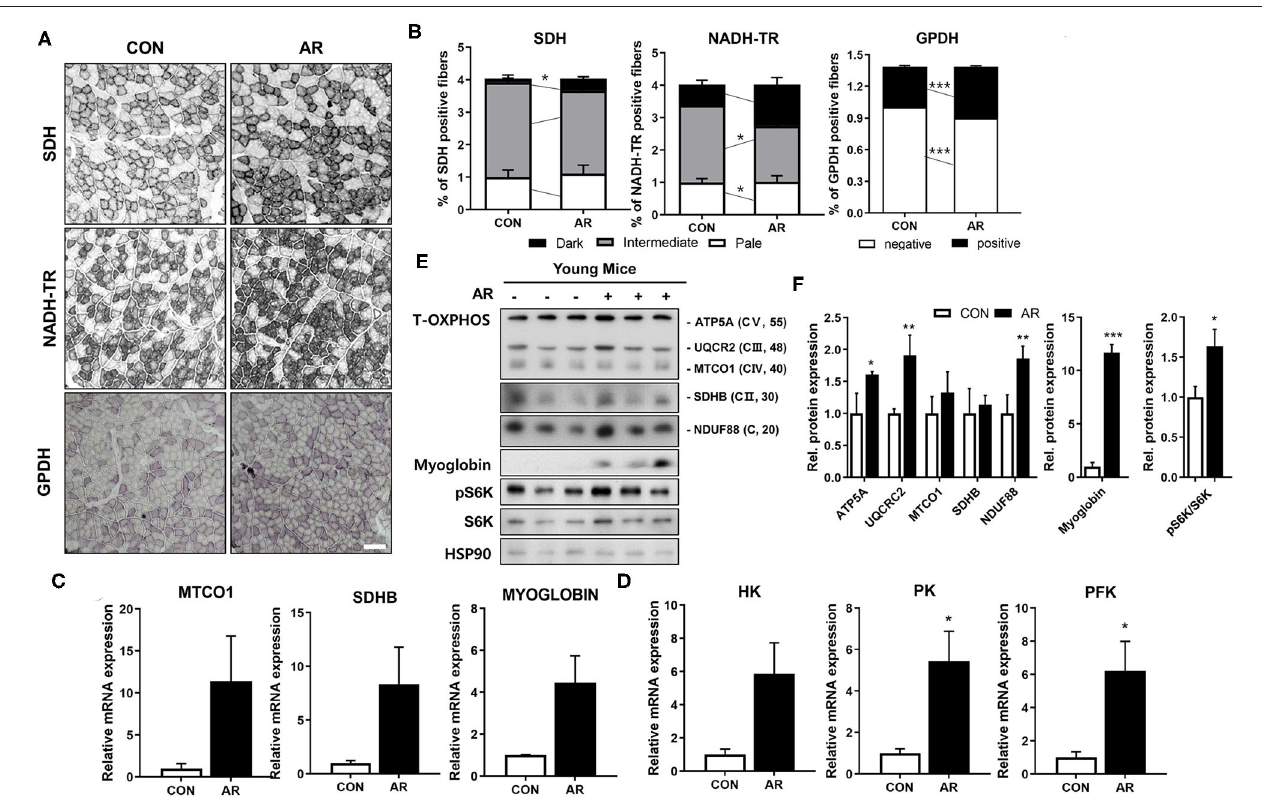
FIGURE 5 | AR increases muscle metabolism in young mice. (A) Histochemical staining for SDH, NADH-TR and GPDH enzymatic activities in TA muscles. Scale bar, 50 µ m. (B) The staining intensities of SDH and NADH-TR are quantified as three different grades (dark, intermediate, and pale) and plotted as a percentile, n = 3. An unpaired two-tailed student’s t -test. (C) qRT-PCR analysis for expression of mitochondrial genes (MTCO1, SDHB) and myoglobin in TA muscles. (D) qRT-PCR analysis for expression of glucose metabolism-related genes in TA muscles. An unpaired two-tailed student’s t -test. (E) Immunoblotting analysis for the expression of Total-OXPHOS, myoglobin and S6K in Qu muscles. (F) Quantification of the levels of total-OxPHOS proteins from panel E, n = 3. An unpaired two-tailed student’s t -test. The data represent the mean ± SEM ( n = 3). * P < 0.05, ** P < 0.01 and *** P < 0.001. AR, Aronia extract; TA, tibialis anterior; SDH, succinate dehydrogenase; GPDH, glycerol-3-phosphate dehydrogenase; NADH-TR, nicotinamide adenine dinucleotide tetrazolium